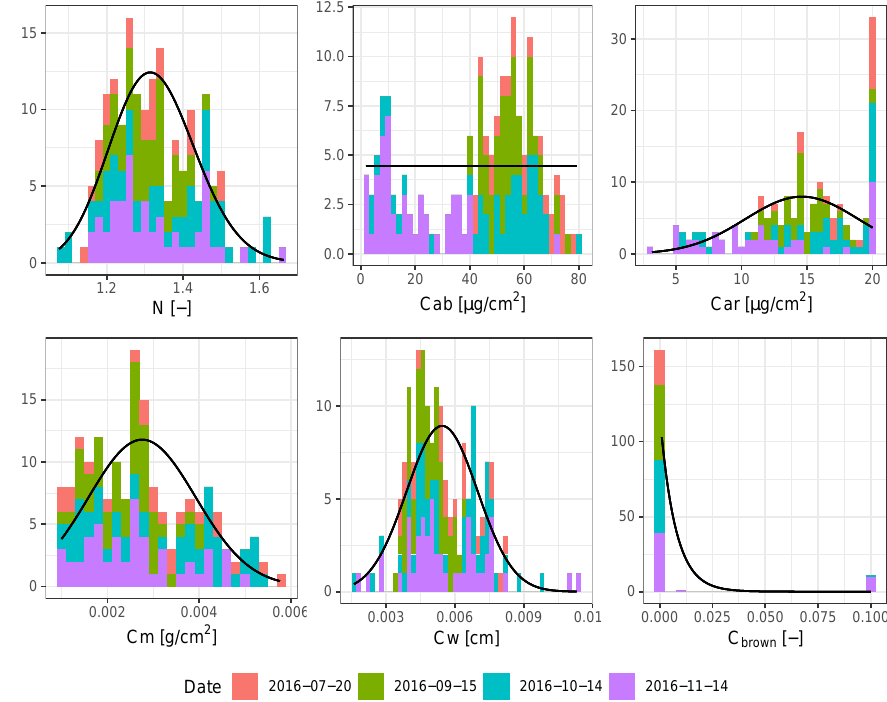
Figure 7. Leaf chemical properties based on PROSPECT inversions of 173 leaf samples. Leaf properties are leaf structure parameter (N), Chlorophyll a and b ( C ab ), leaf carotenoid content (Car), leaf dry matter content ( C m ), leaf water content ( C w ), and leaf brown pigment fraction ( C brown ). Stacks are coloured by acquisition date. Solid lines are fitted density models. Ordinate axis represents observation counts and modelled counts for the observations and the fitted models,